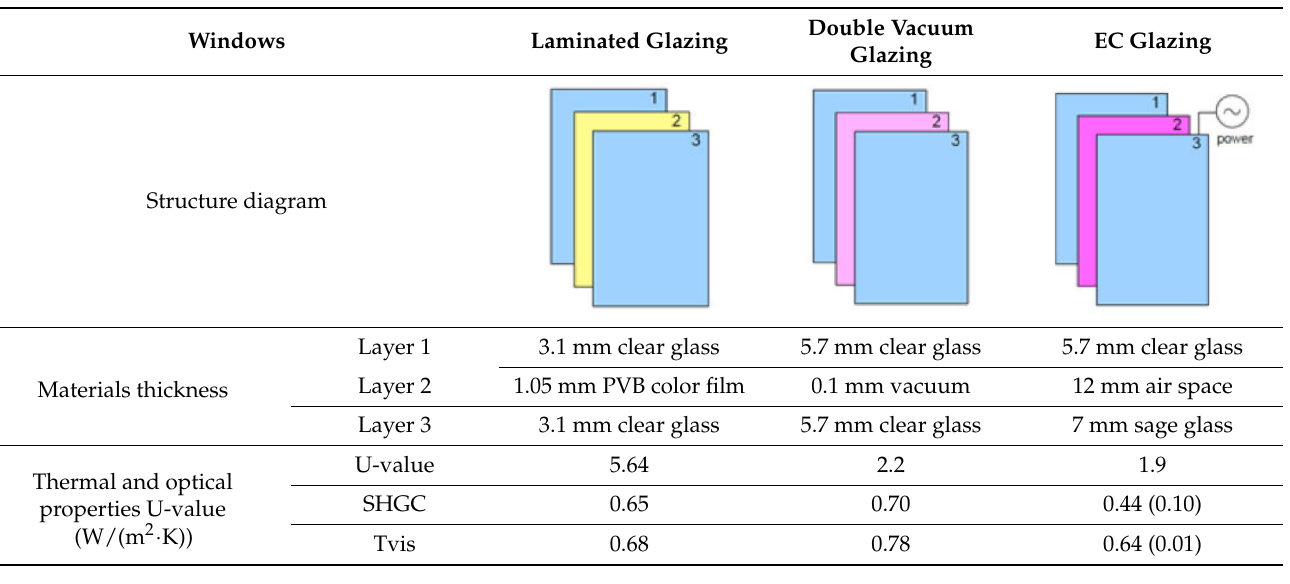
Table 3. Thermal and optical characteristics of